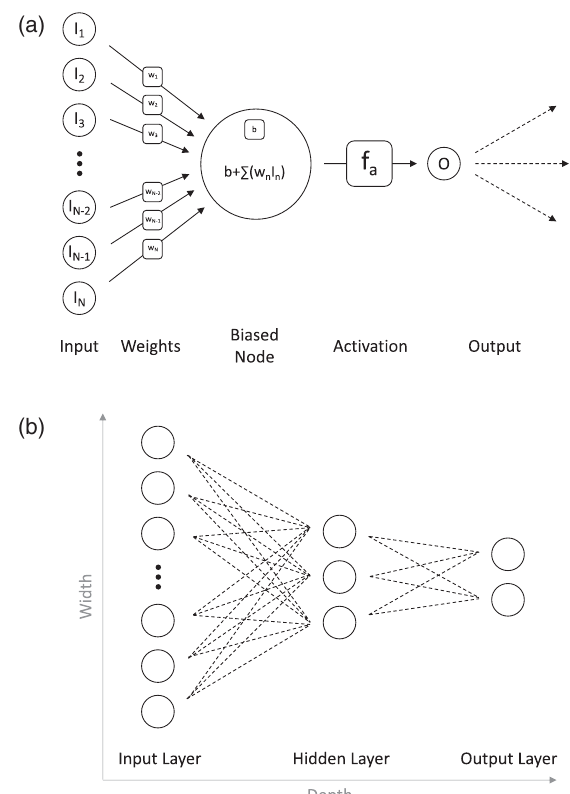
FIG. 2. (a) Schematic of an artificial neuron with N weighted inputs and one output O . (b) Exemplary fully connected neural network with one hidden